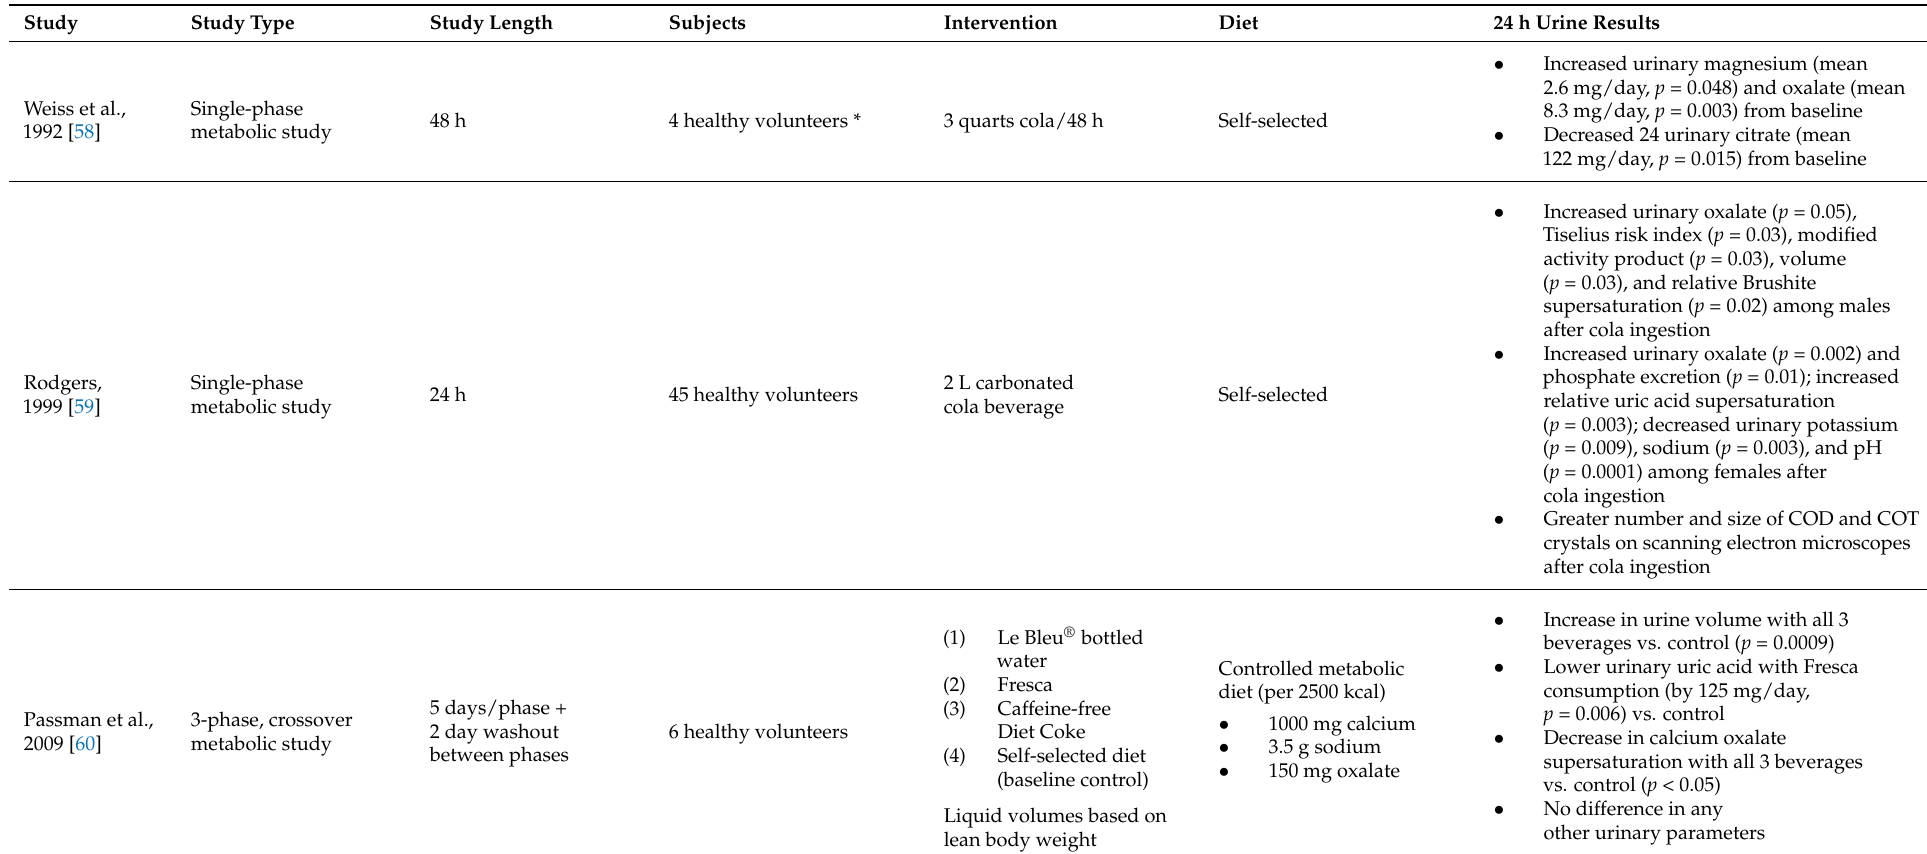
Table 2. Summary of studies evaluating the effect of sodas, colas, and sports drinks on urinary